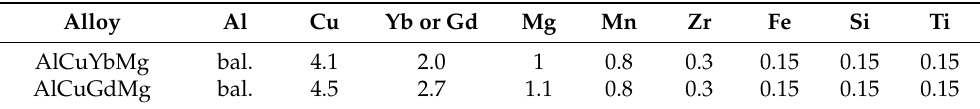
Table 1. Chemical composition (wt.%) of the investigated alloys. Alloy